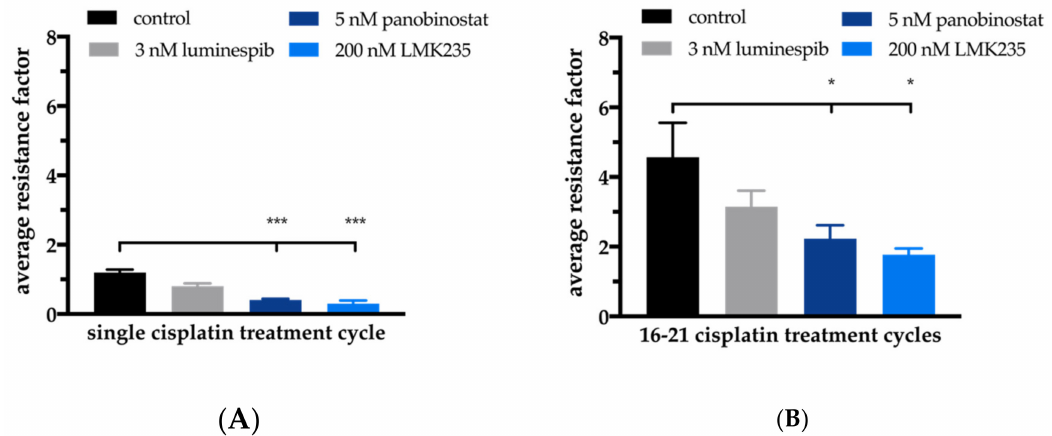
Figure 9. E ff ects of HDACi or HSP90i on short-term ( A ) or long-term ( B ) cisplatin stress-induced changes of cisplatin sensitivity in A2780 ovarian cancer cells. Average resistance factors of cisplatin after single cisplatin treatment cycle (“cisplatin stress”) (A) or after 16–21 cisplatin treatment cycles (averaged data over Treatment Cycles 16–21) in A2780 cells. Cisplatin treatment cycle means treatment for 6 h with an IC 50 of cisplatin alone (“control”) or in permanent presence of 3 nM luminespib, 5 nM panobinostat or 200 nM LMK235. Resistance factors were calculated by dividing the IC 50 of cisplatin obtained after a treatment cycle (“stressed” cells) by the IC 50 of cisplatin from unstressed A2780 cells. Statistical analysis was performed using t-test. Levels of significance: * p ≤ 0.05, *** p ≤